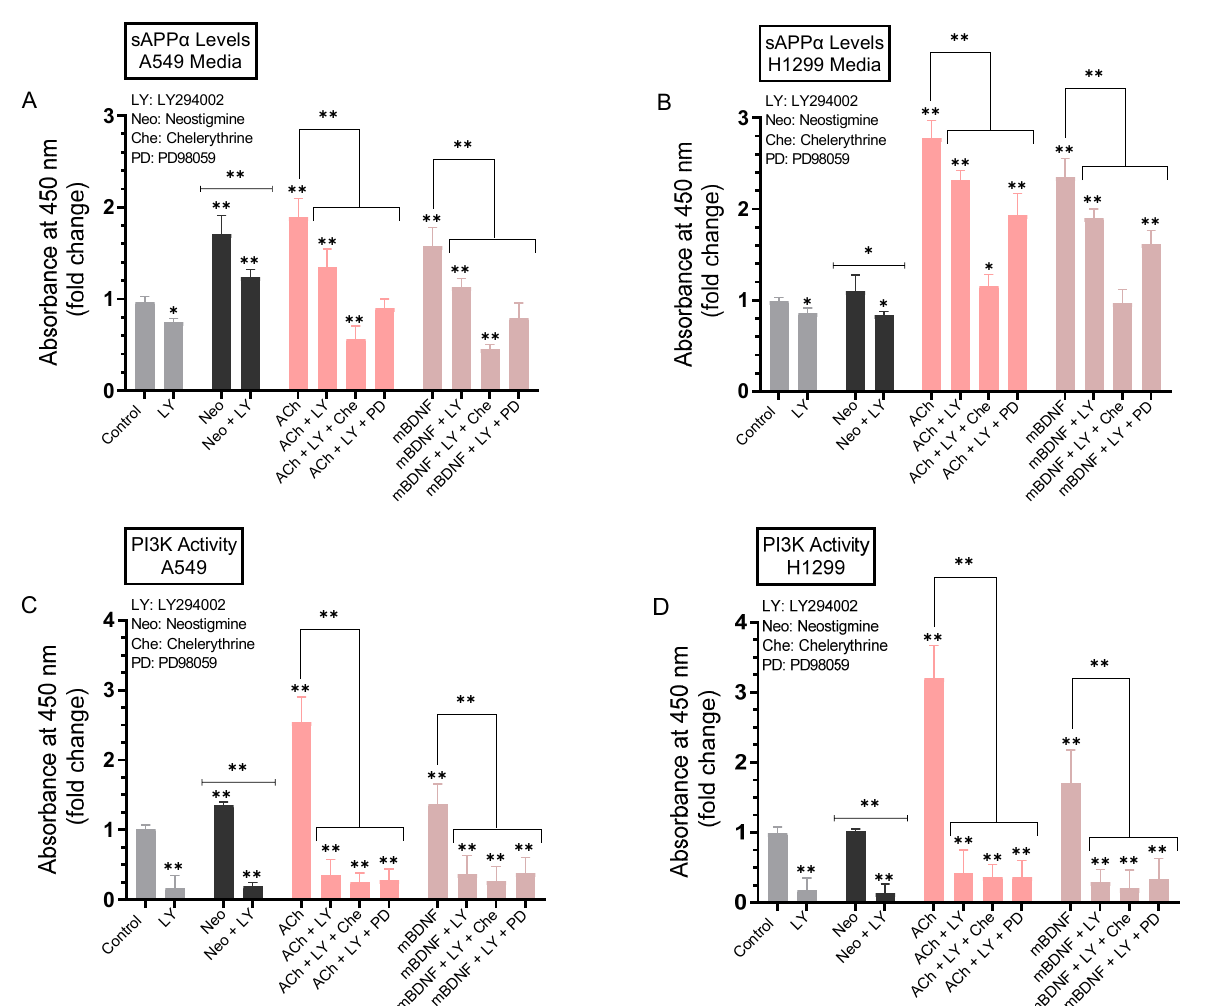
Figure 9. Co-treatment of cells with ACh or mBDNF, the PI3K inhibitor, LY294002, and either the ERK1/2 inhibitor or PKC inhibitor decreased the levels of sAPP α in the media of A549 and H1299 cells to a greater extent than co-treatment with LY294002 alone. Cells (0.2 × 10 5 ) were grown in 10% FBS-supplemented media for 24 h. The following day, the cell monolayers were incubated in serum-free media for 24 h, then treated for 72 h with the PI3K inhibitor (LY294002, 14.5 µ M) alone or in combination with the ERK1/2 inhibitor (PD98059, 50 µ M) or PKC inhibitor (chelerythrine, 7.5 µ M), neostigmine (Neo, 50 µ M), ACh (100 nM), and mBDNF (5 nM). Levels of sAPP α released into the culture media of A549 ( A ) and H1299 ( B ) cells during the 3-day incubation period were measured as described in the Methods section on the same amount of protein (3 µ L of 600 µ g/mL total protein) of each sample. PI3K activity was measured in A549 ( C ) and H1299 ( D ) cells as described in the Methods section. Data from five independent assays, each carried out in triplicate, were averaged, normalized, and expressed as fold change relative to untreated cells (control) using the GraphPad 9.4.1 software. The graphs summarize the results expressed as means ± SD (n = 5). Asterisks indicate a statistically significant difference from the corresponding control of each cell line while absence of asterisks indicates no significance, Mann–Whitney test. Statistical differences between different groups were analyzed by an ordinary one-way analysis of variance (ANOVA) followed by Tukey’s post-hoc multiple comparison test. * p < 0.05, ** p < 0.01. Incubation of A549 cells with the PI3K inhibitor resulted in ~1.35-fold decrease in the levels of sAPP α while that decrease was ~1.15-fold in the media of H1299 cells treated under the same conditions (Figure 9A,B). Treatment of cells with LY294002 and either neostigmine, ACh, or mBDNF led to a ~1.40-fold decrease in the levels of sAPP α in A549 cell